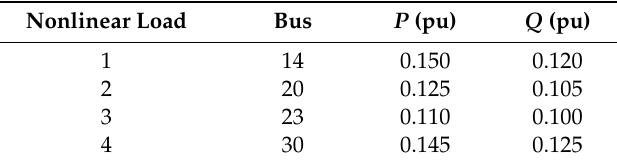
Figure 6. Modified IEEE 33-bus test network. Table 1. Nonlinear loads of the network.